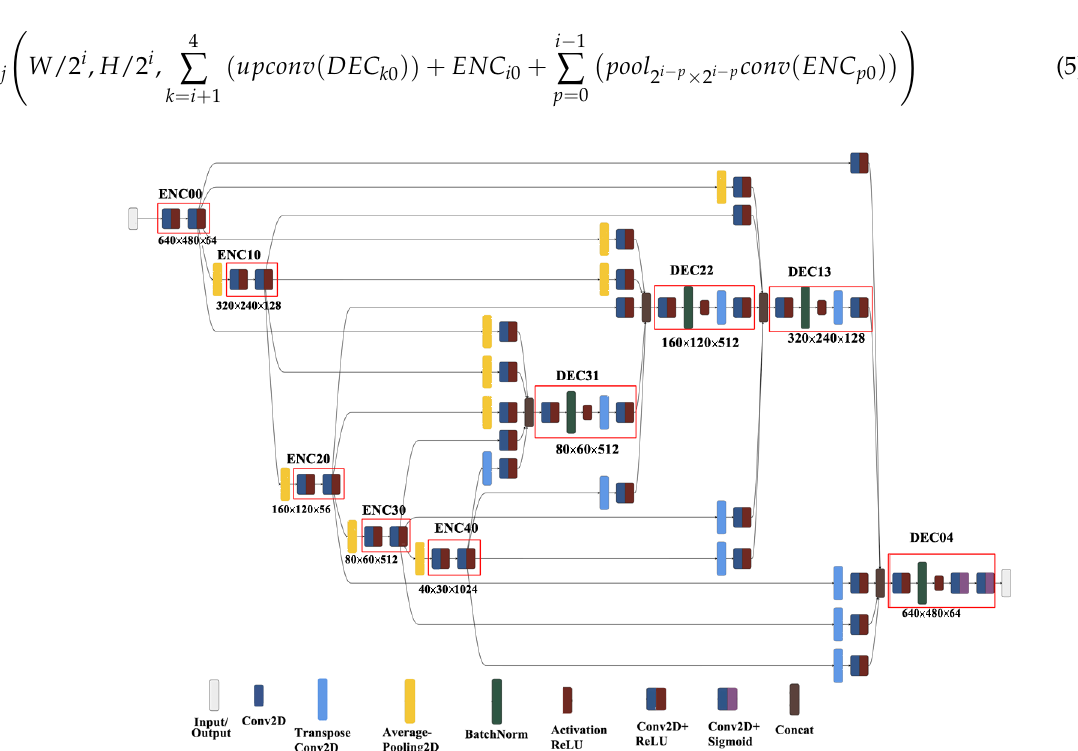
Figure 10. Our implementation of